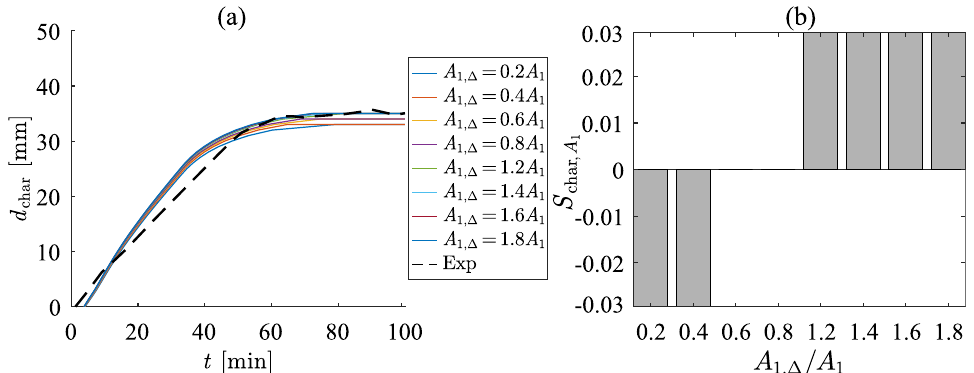
Fig. 3 a The development of charring depth for varied parameter A 1, (cid:31) . b Sensitivity index S char, A charring depth